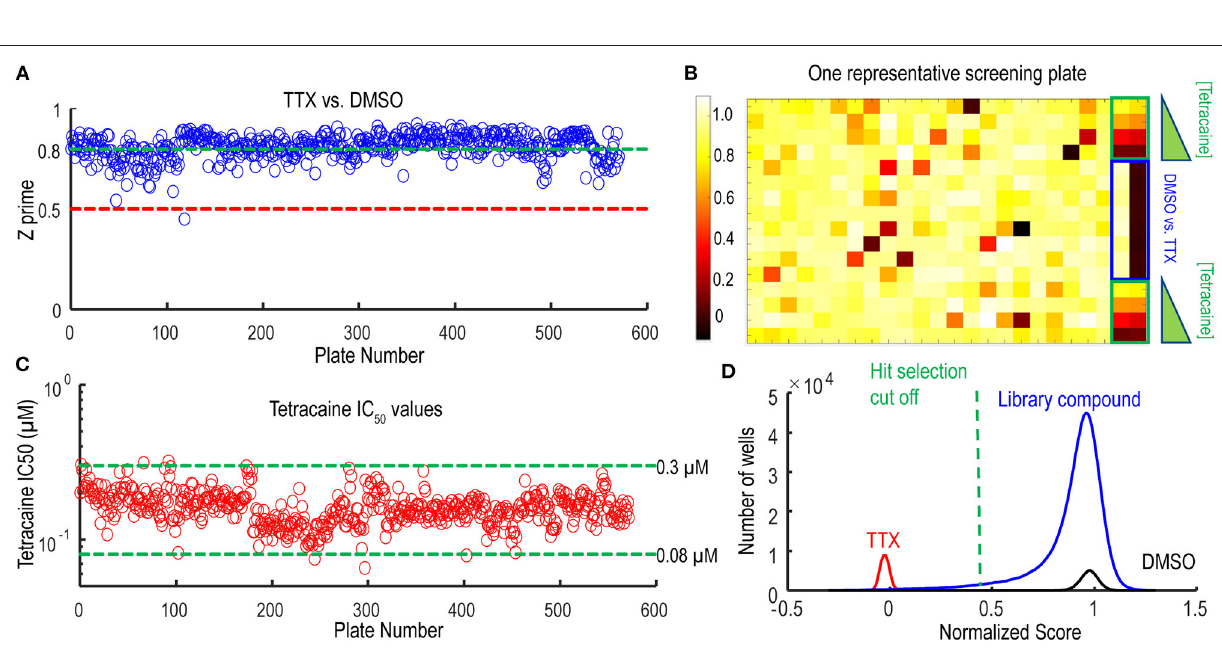
Frontiers in Molecular Neuroscience | www.frontiersin.org